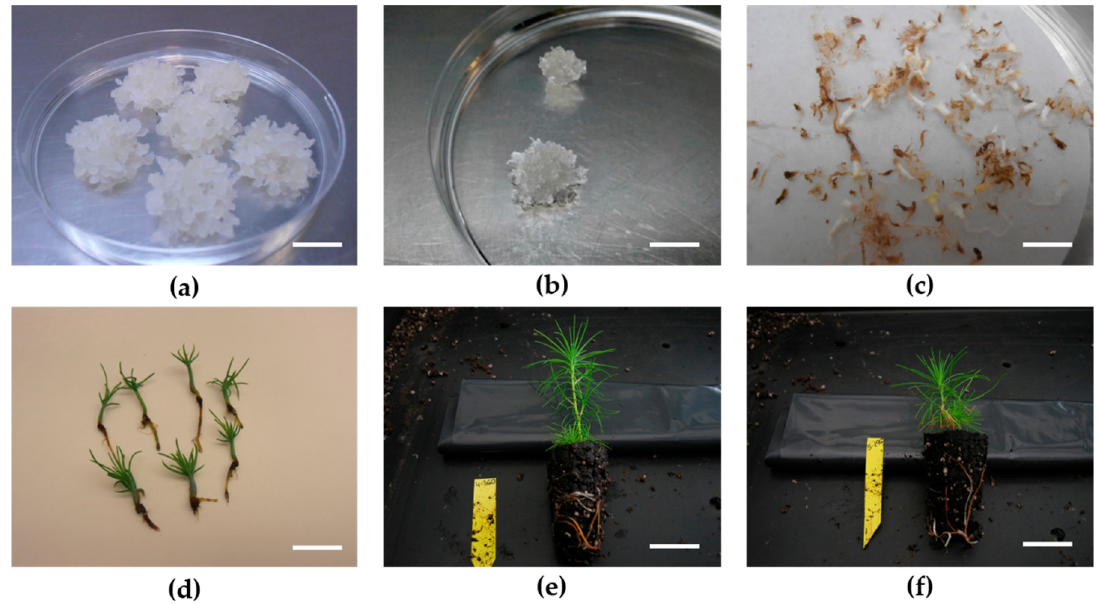
Figure 1. ( a ) Pinus attenuata × Pinus radiata embryonal masses at proliferation stage, bar: 13 mm. ( b ) Pinus radiata × Pinus attenuata embryonal masses regenerated after five years of storage at − 80 ◦ C, bar: 10 mm. ( c ) P inus attenuata × Pinus radiata somatic embryos, bar: 7 mm. ( d ) Pinus radiata × Pinus attenuata somatic plantlets after six weeks of in vitro germination, bar: 15 mm. ( e ) Pinus radiata × Pinus attenuata somatic plantlet after two months in the greenhouse, bar: 35 mm. ( f ) Pinus attenuata × Pinus radiata somatic plant after two months in the greenhouse, bar: 26